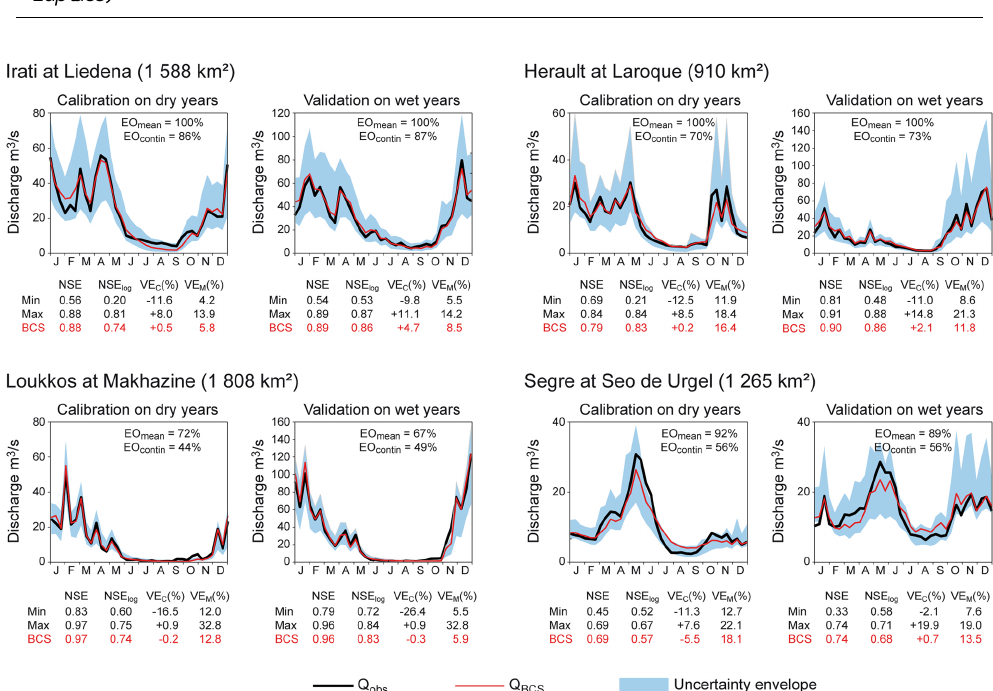
Figure 2. Hydrological simulation bounds in calibration (dry years) and validation (wet years) over 1986–2005. Minimum and maximum values for each goodness-of-fit criterion are extracted from the Pareto-solutions retained and composing the uncertainty bounds. BSC stands for the solution minimizing the aggregated function γ (Eq. 5) among the Pareto-solutions. EO mean and EO contin stand for the proportion of observations enclosed within the Pareto-bounds over the multi-year period in calibration or validation for the mean and continuous interannual hydrograph